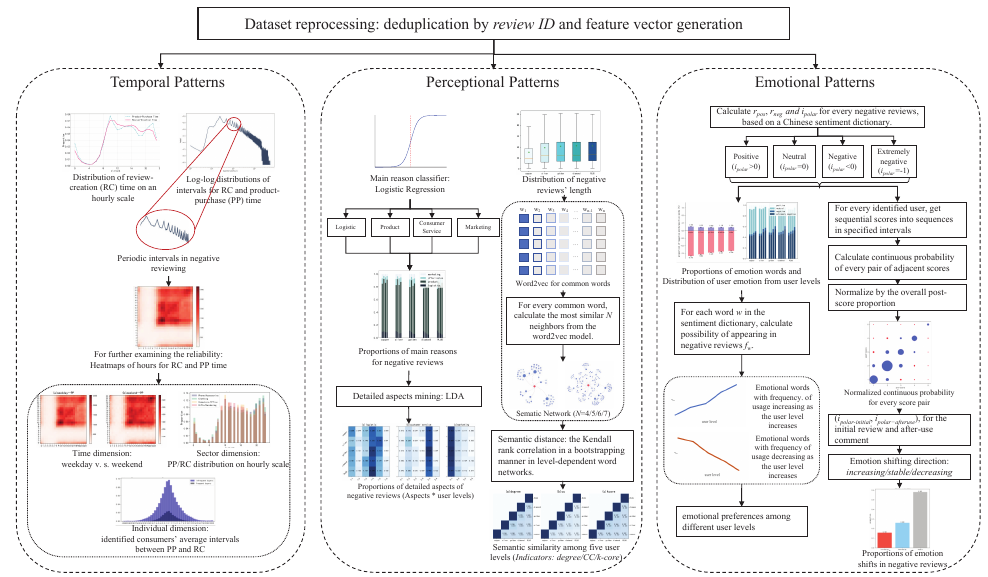
Figure 2. The flow chart of methodological and analysis